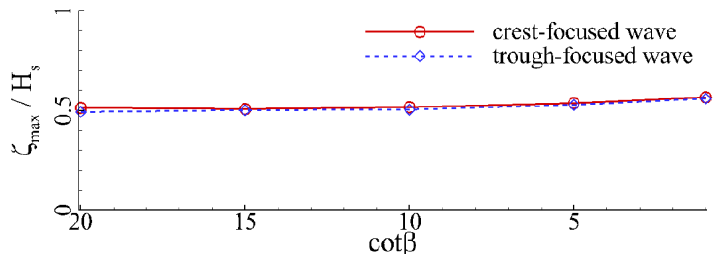
Figure 48. Space distributions of the maximum water elevation.